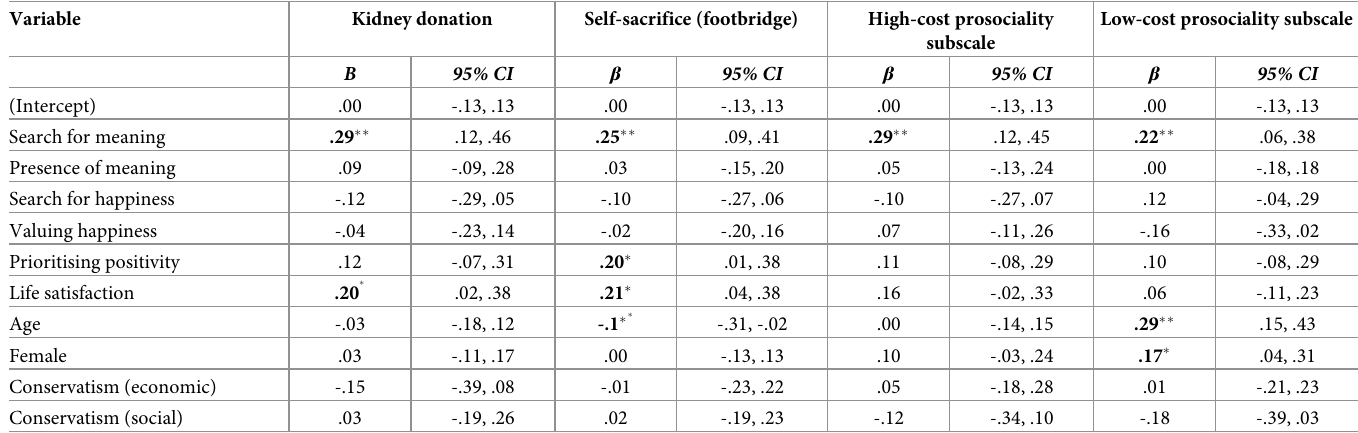
Table 6. Multiple regressions predicting costly prosociality with search for meaning in Study